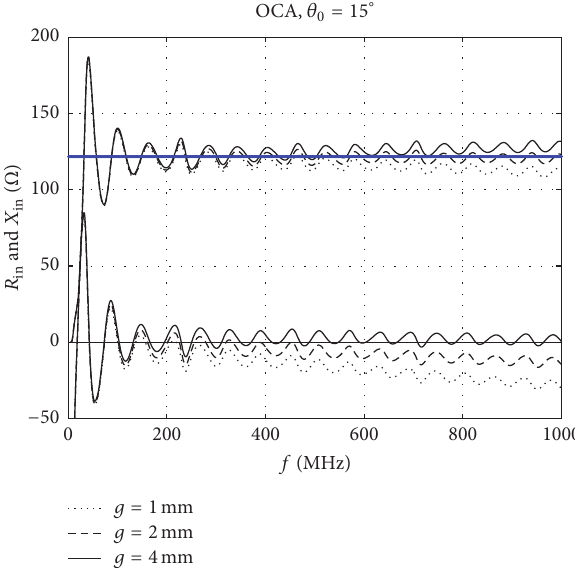
Figure 19: Design chart for the CST simulated SCCA example with DF min = 20.